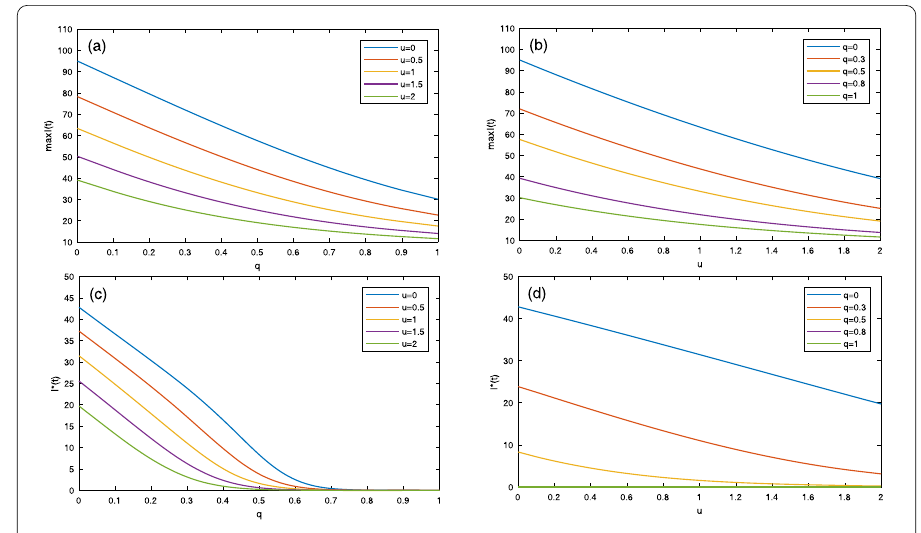
Figure 3 The epidemic size and the endemic number: ( a ) the epidemic size when q varies and u = 0,0.5,1,1.5,2; ( b ) the epidemic size when u varies and q = 0,0.3,0.5,0.8,1; ( c ) the endemic number when when q varies and u = 0,0.5,1,1.5,2; and ( d ) the endemic number when u varies and q =